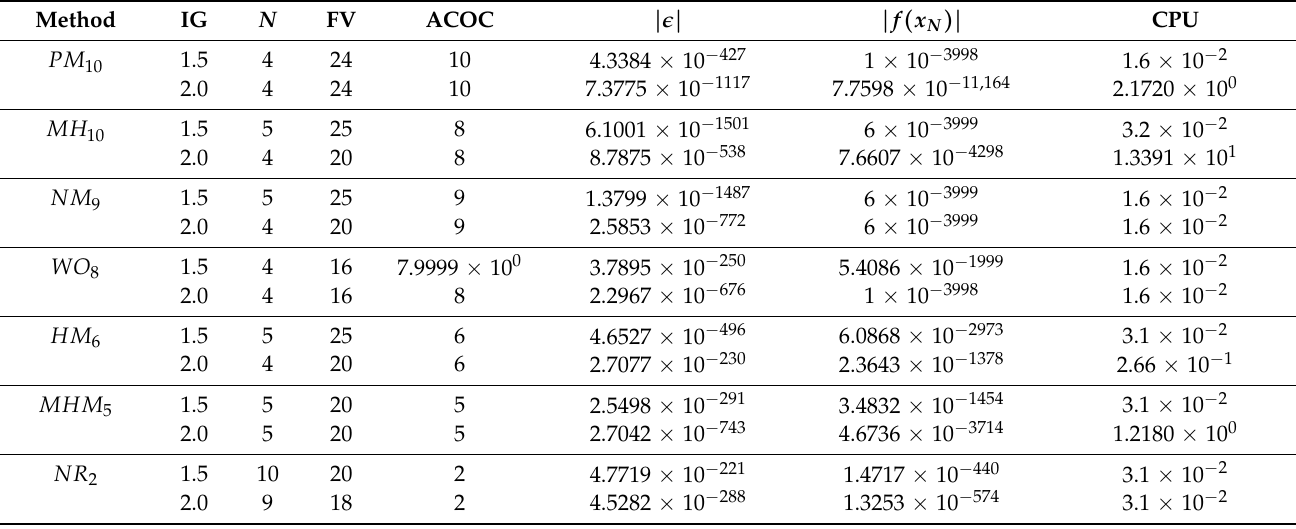
Table 3. Numerical results for problem 2: g 1 ( x )